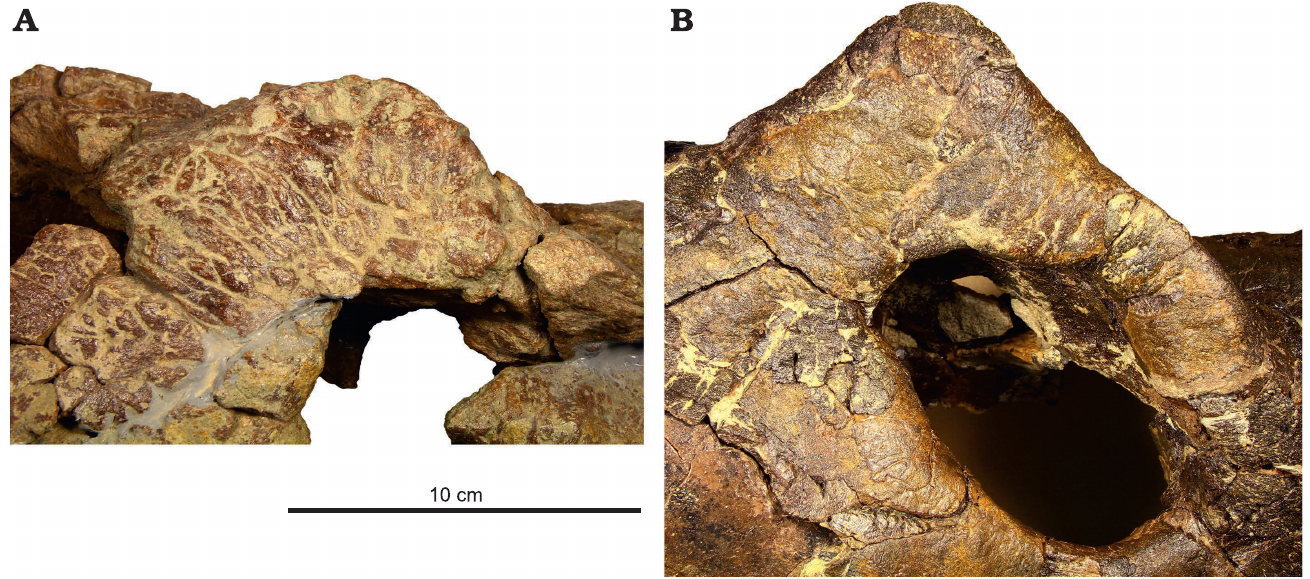
Fig. 3. Right lateral views of supraorbital ornamentation of Einiosaurus procurvicornis Sampson, 1995, MOR 456 8-8-87-1 ( A ) and eucentrosauran ( Einiosaurus procurvicornis or Achelousaurus horneri Sampson, 1995), MOR 591 ( B ) from the Campanian Two Medicine Formation, Montana,